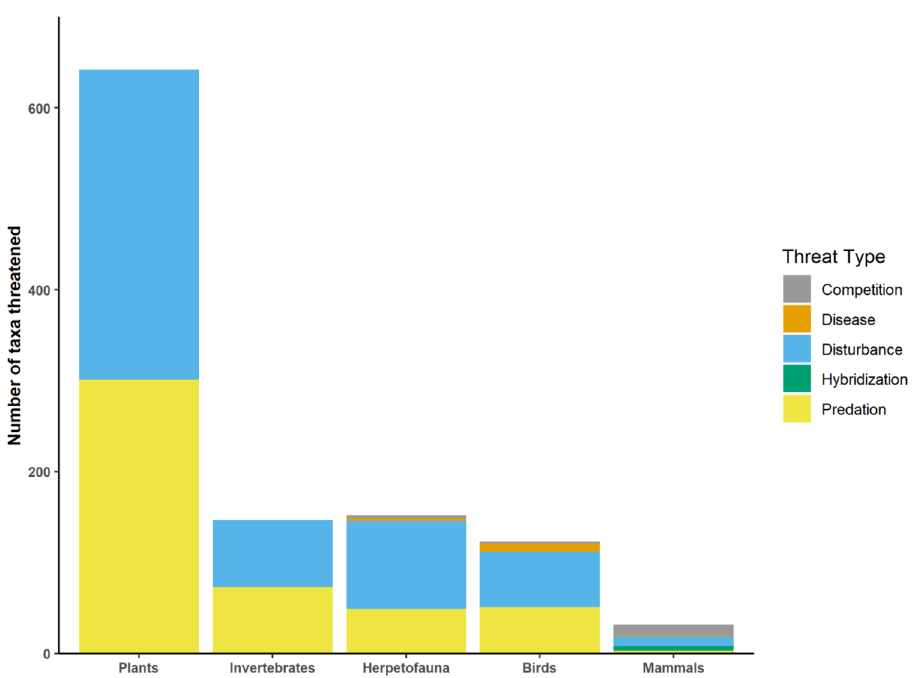
Figure 3. Quantity of all taxa on the IUCN Red List that are (extant) or have been (extinct), threatened by different wild pig threat types (e.g. Disturbance). Fill colors are the number of taxa for each taxonomic